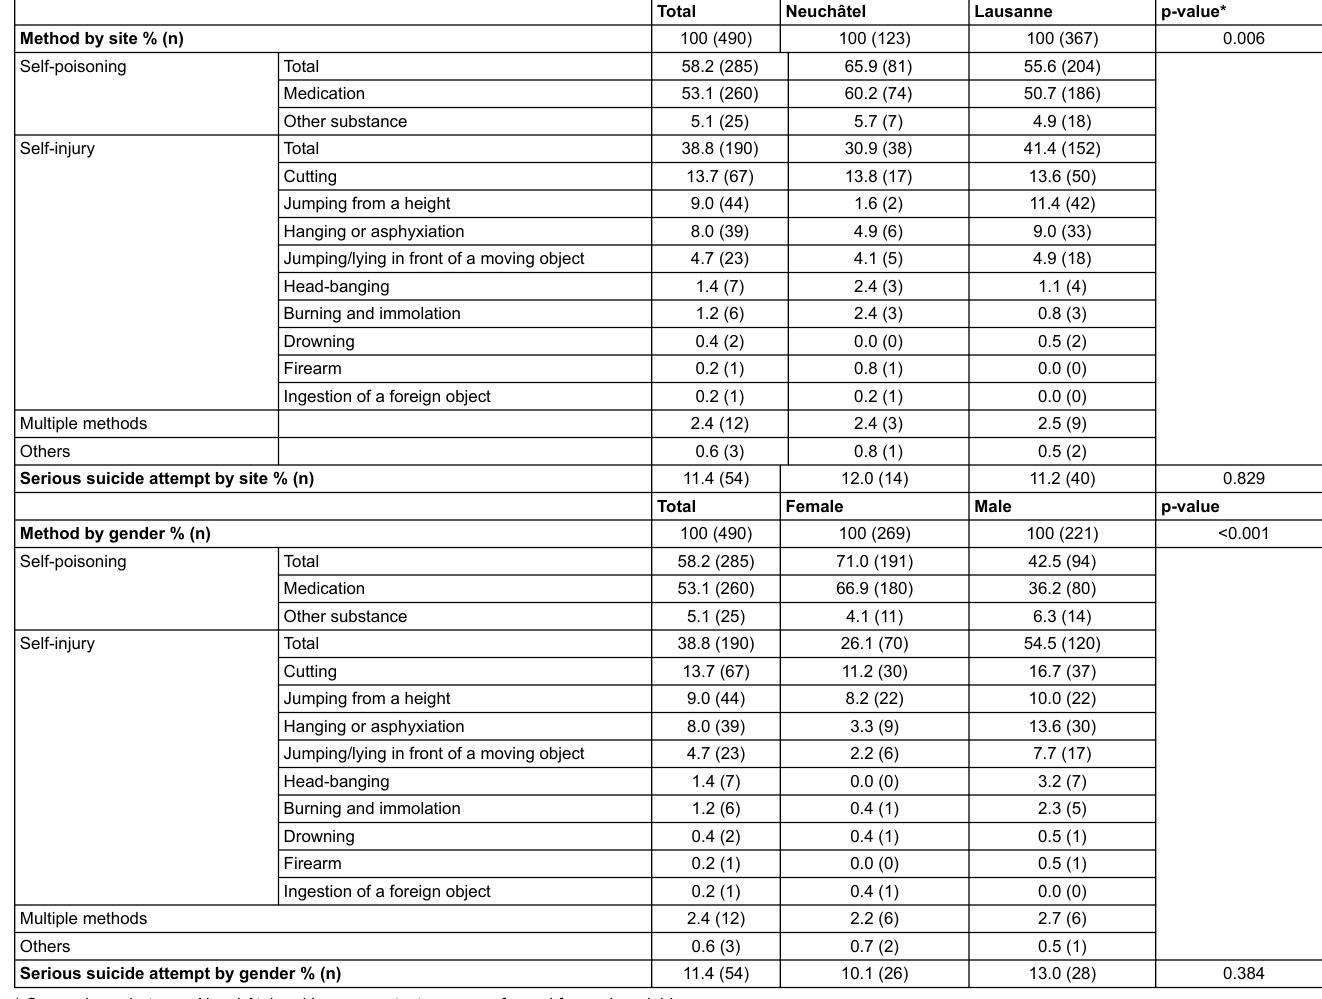
Table 5: Method and severity by sites and gende r